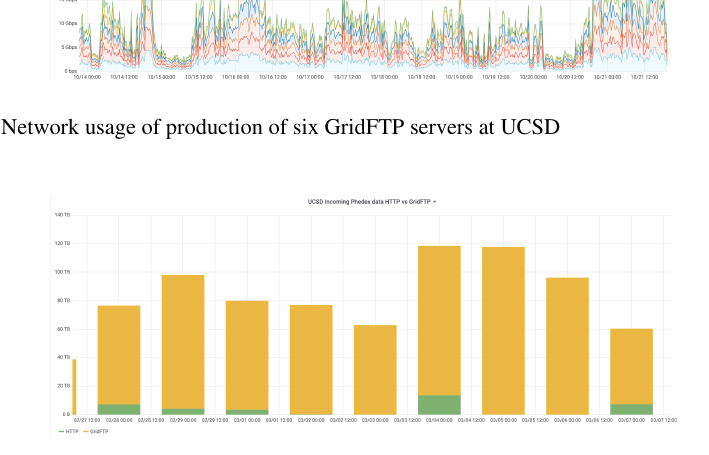
Figure 5. Current production transfers discriminated between GSIFTP (Yellow) and HTTP